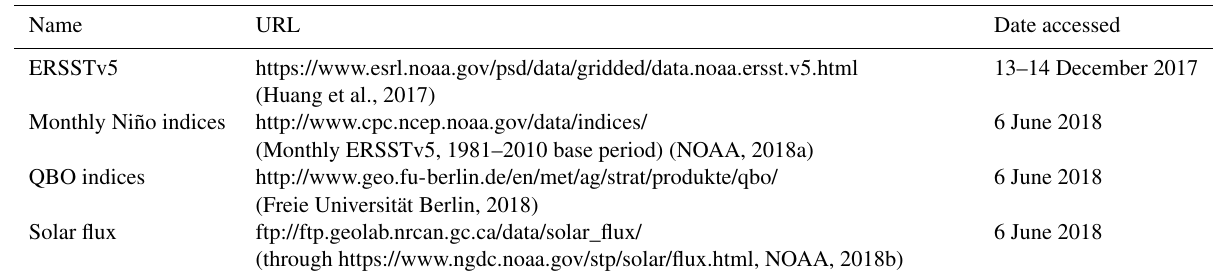
Table 4. Monthly mean data sets for climatic